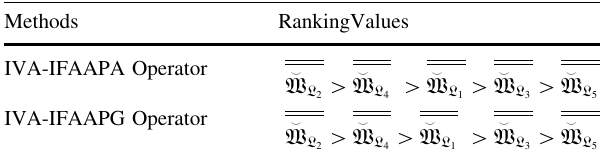
Table 7 The score values Table 8 The ranking